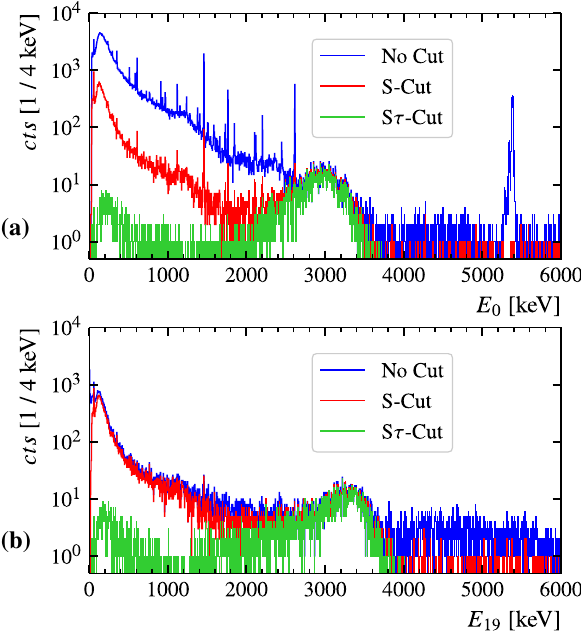
Fig. 11 Distributions of a τ 0 and b τ 19 for events selected with the S-cut from AST at ϕ = 257 . 9 ◦ and r = 23 . 8mm and from BG. The solid line is the function T , see Eq. (2), fitted to the distributions of the 241 Am measurement. The ± 2 σ interval, used for the τ -cut, is indicated by the vertical dashed lines